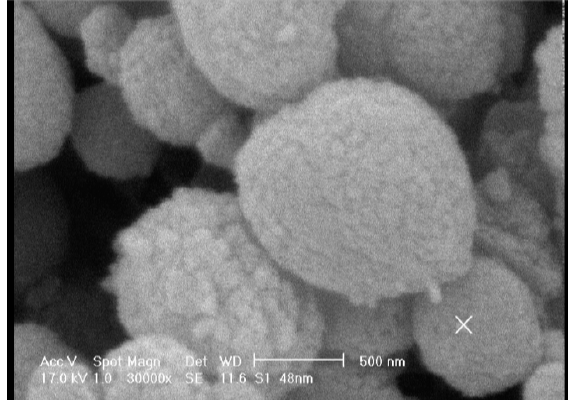
Fig. 2. SEM image of the Cr